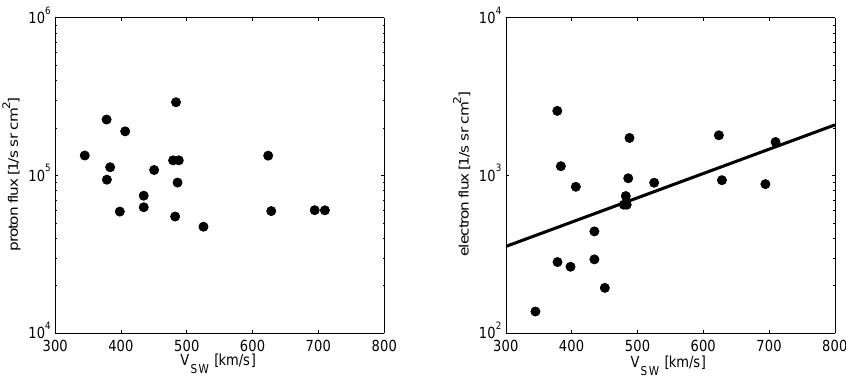
Fig. 7. Total energetic particle fluxes in the exterior cusp as a function of solar wind speed. Proton fluxes are shown in the left and electron fluxes in the right.